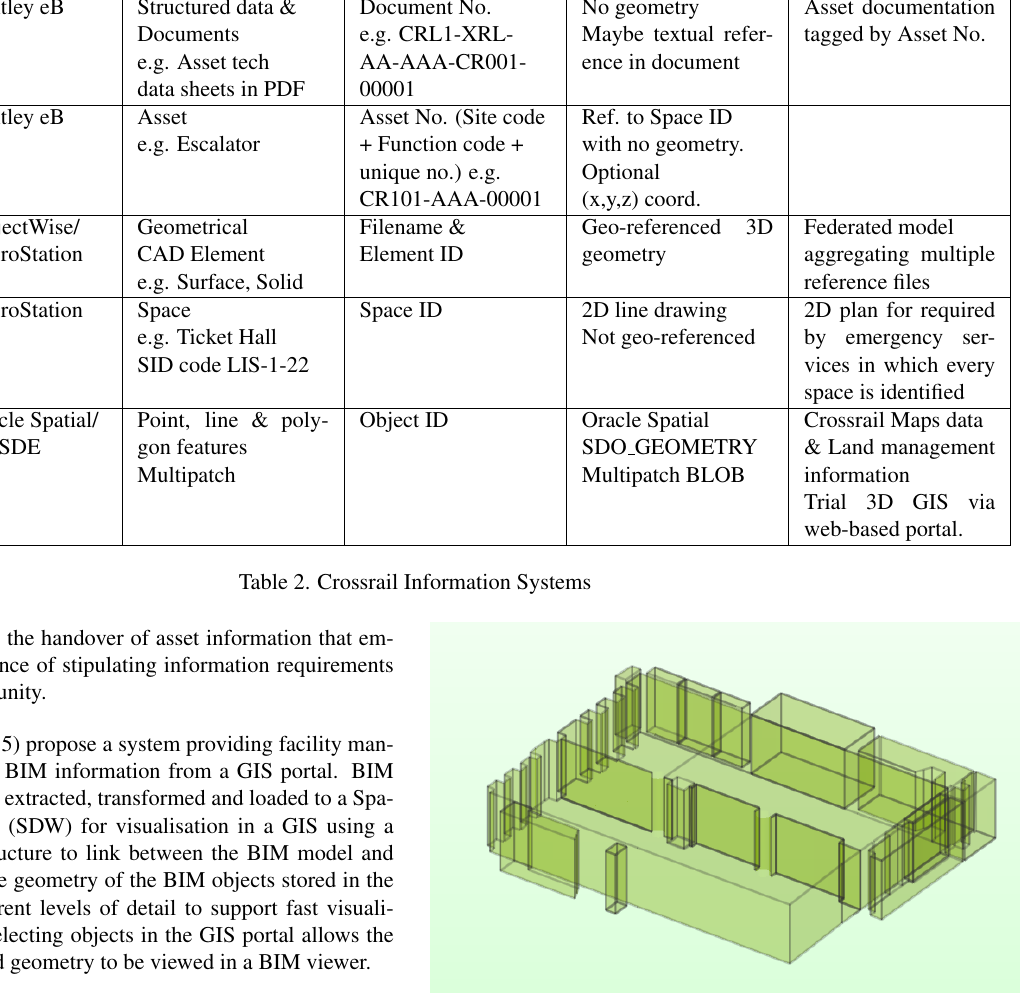
Figure 1. Fire Plan spaces - Station ticket